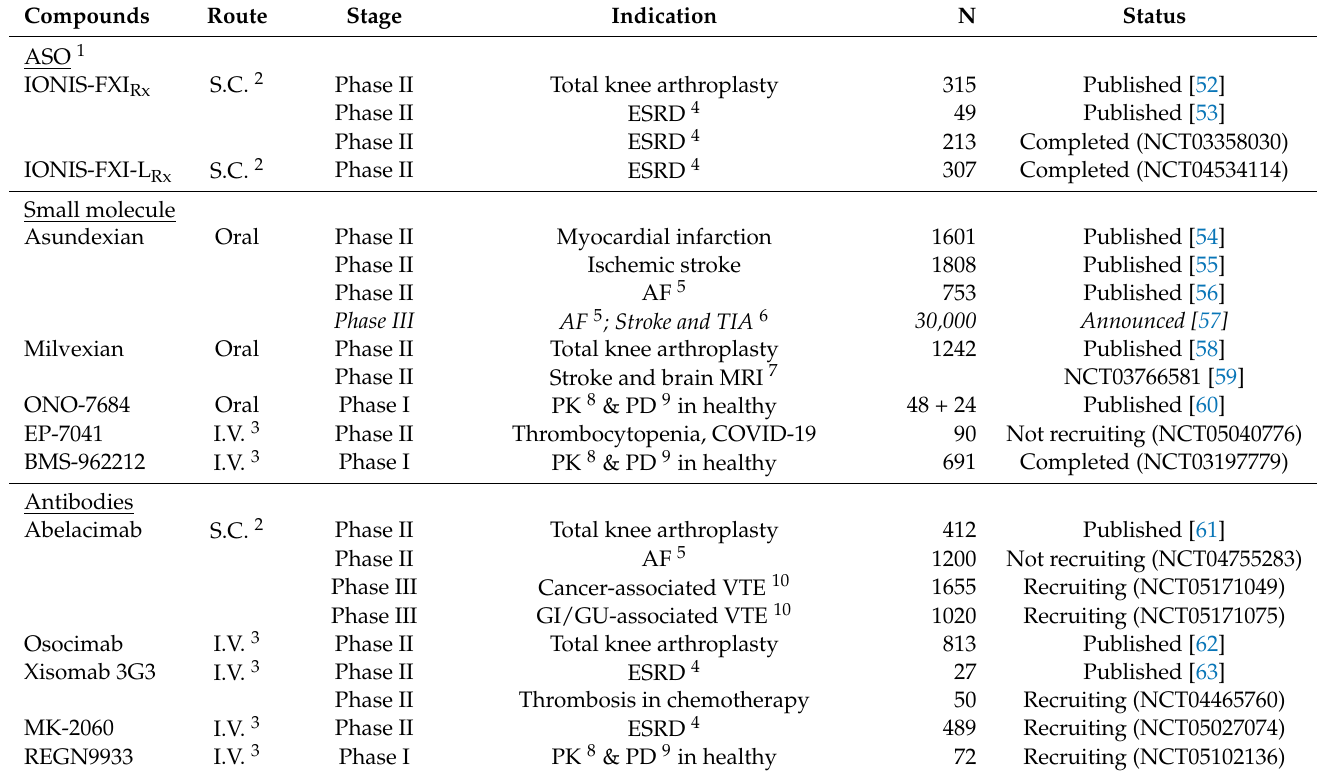
Table 1. Inhibitors of FXI/FXIa in various stages of clinical